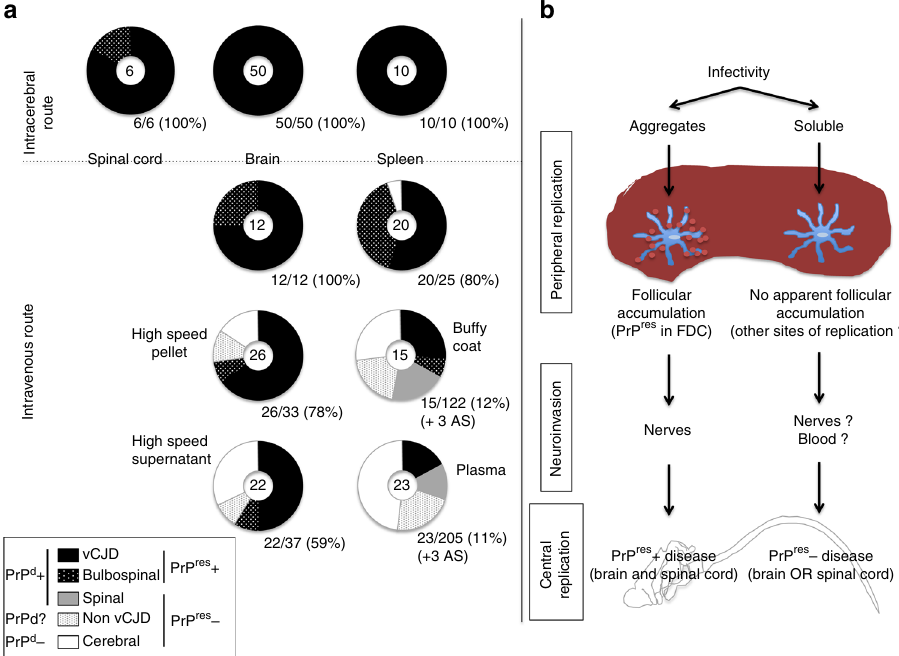
Fig. 9 a The pattern of distribution of disease pro fi les in mice according to the kind of inocula (brain, soluble infectivity or blood products). For each inoculum, the pattern of disease pro fi les observed in affected mice (numbers at the centre of each circle) is depicted in fi ve categories grouped according to their status towards abnormal PrP: classical vCJD pattern (protease-resistant PrP d , black), bulbospinal (BS) pattern (protease-resistant PrP d , white- spotted black), spinal (S) pro fi le (protease-sensitive PrP d , grey) or cerebral involvement grouping cerebral (C), bulbar (B) pro fi les and animals with only neuronal lesions (NL) (no detectable PrP d , white). The fi fth category (grey-spotted white) corresponds to the non-vCJD mice (affected mice devoid of PrP res but not sampled for histology. They might present either spinal pro fi le or cerebral involvement). Below each circular panel are speci fi ed the percentage of transmission and the numbers of aging spinal animals (AS). b Two different putative pathophysiological pathways may occur depending on the aggregated or soluble nature of the initial Blood sample preparations . Blood samples from three UK and one French vCJD patients were used in parallel with primate blood samples drawn into sodium citrate. Corresponding RBCC, plasma and buffy coat fractions were collected after centrifugation at 2000× g for 13 min. Deleukocyted blood samples were prepared by pooling RBCC and plasma after fractionation. Deleukocyted RBCC were obtained through fi ltration on a commercial device (LST2, MacoPharma, < 1× 10 6 leuco- cytes/unit after fi ltration) and then re-suspended in corresponding plasmas in proportions used for paediatric transfusion 53 . Sixty Swiss mice were inoculated intracerebrally with 2mg of brain from Swiss mice infected with the vCJD-adapted strain. Their blood was collected 20 weeks post inoculation, pooled and centrifuged at 2000× g for 13 min. Buffy coat and plasma were recovered after fractionation. Inoculation of blood products . Transfusion experiments in primates are exten- sively described in the Supplementary Text 1. Primates were injected IV with volumes of blood products equivalent to 40ml of whole blood unless otherwise stated. Mice were inoculated IV with 0.2 ml of plasma or buffy coat (equivalent to 0.5 and 1ml of whole blood, respectively) derived from either vCJD-infected mice, vCJD-infected primates (D3, D4, D5, D6, D19 and R15) or myelopathic primates D7 and R5 that developed the myelopathic syndrome without or with accumula- tion of PrP d in their spinal cord, respectively. Transmission experiments . C57Bl/6 and Swiss mice were inoculated intracere- brally (2 mg of tissue) or IV (0.2 mg of tissue) with brain, spinal cord or spleen homogenates from mice or primates.